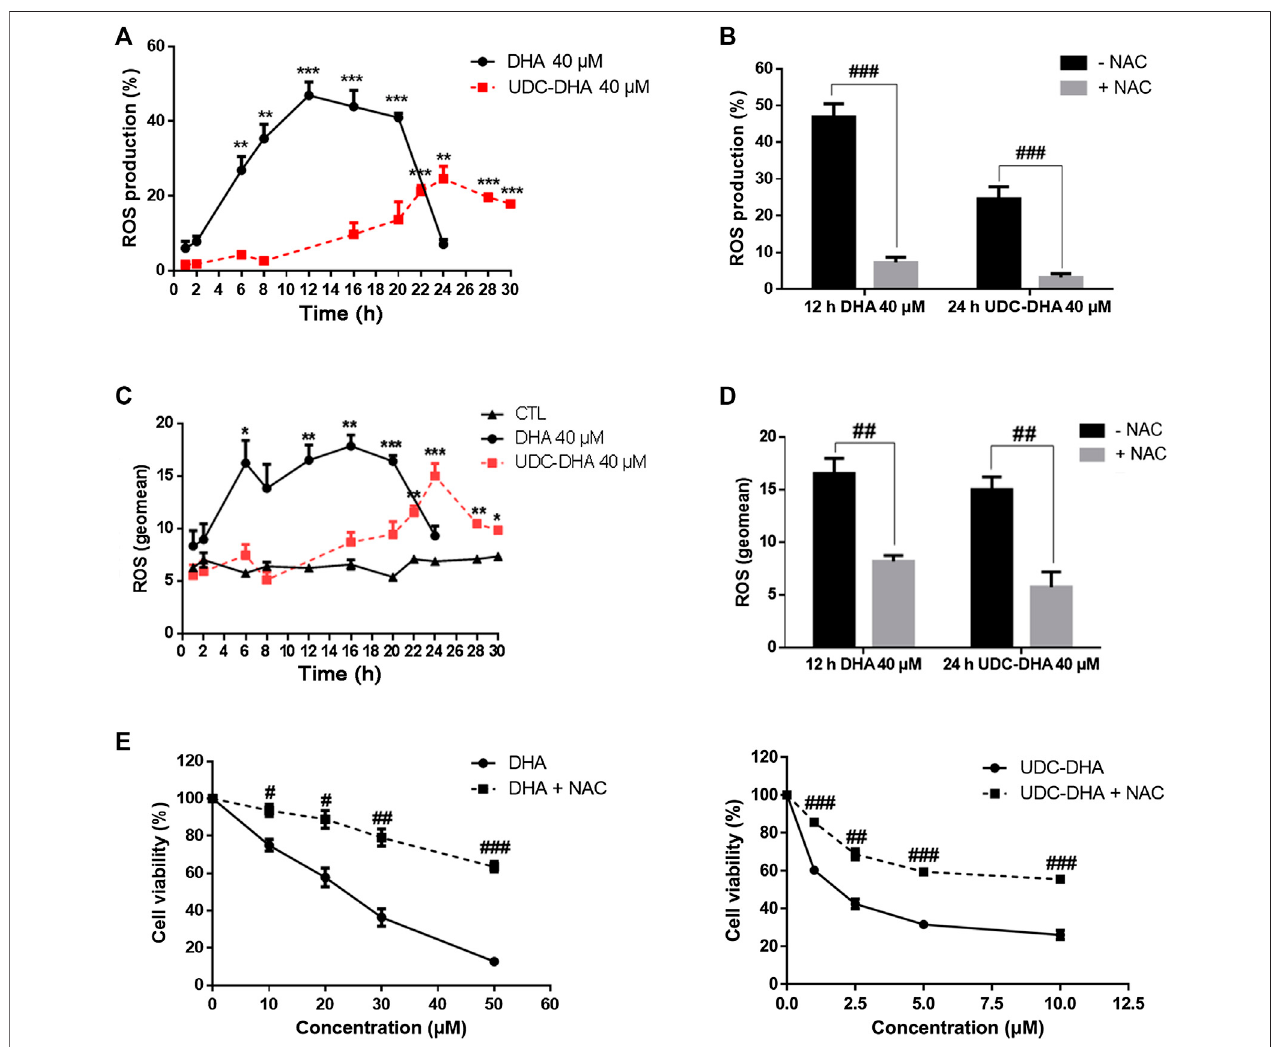
FIGURE4| EffectsofDHAandUDC-DHAonROSgenerationinHepG2cells.DHAandUDC-DHAinducedROSovertimeinHepG2cells (A,C) ,andNACreversed ROS generation induced by DHA and UDC-DHA (B,D) . HepG2 cells were treated with indicated concentrations of DHA or UDC-DHA for various time periods with or without 2 mM of NAC. DCFH-DA (10 μ M) was added to the cells 30 min before termination of the treatment. Cells were then harvested for fl ow cytometric analysis of DCF fl uorescence. The percentages of cells with ROS production ( A,B ) or the geomean of ROS ( C,D ) were analyzed by FlowJo software. ( E ) NAC reversed the growth inhibitory effect of DHA and UDC-DHA. HepG2 cells were treated with various concentrations of DHA or UDC-DHA in the absence or presence of 2 mM of NAC for 72 h, followed by the MTT assay to measure cell viability. Data are presented as mean ± SEM of at least three independent experiments. *, p < 0.05; **, p < 0.01; ***, p < 0.001 vs. the control group. #, p < 0.05; ##, p < 0.01; ###, p < 0.001 vs. respective non-NAC treatment group.